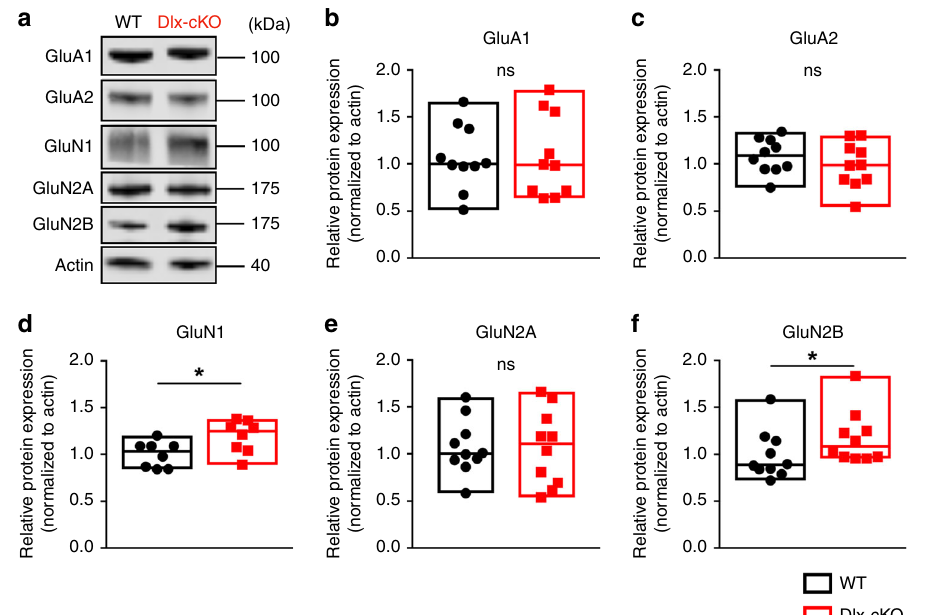
Fig. 4 Dlx-cKO mice have an upregulation of NMDA receptors at the postsynaptic membrane. a Representative western blot results for several major ionotropic glutamate receptor subunits from postsynaptic density membrane fractions. Samples are from pairs of WT and Dlx-cKO littermates. b – f Dlx- cKO mice show a selective increase in levels of GluN1 and GluN2B, two of the major subunits that compose the NMDA receptor (WT, n = 10 mice; Dlx- cKO, n = 10 mice; unpaired t- test or Mann – Whitney test). Full-scan western blots of all samples are available in Supplemental Fig. 6. * p < 0.05. Source data are provided as a Source Data fi